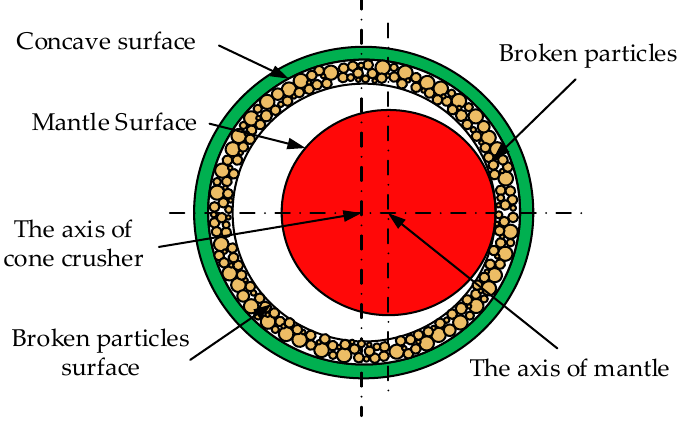
Figure 2. The cross section of cone crusher.